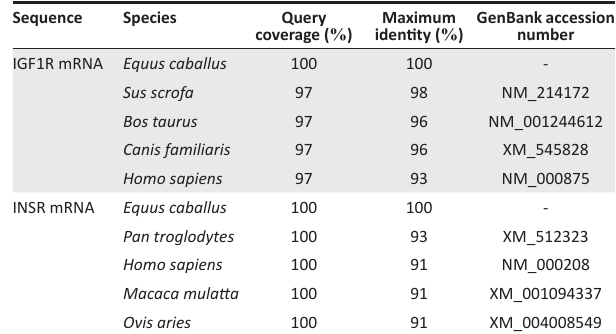
TABLE 1: Results of the discontiguous megablast of the real-time RT-PCR product sequence showing the five most similar IGF1R and INSR mRNA sequences. Sequence